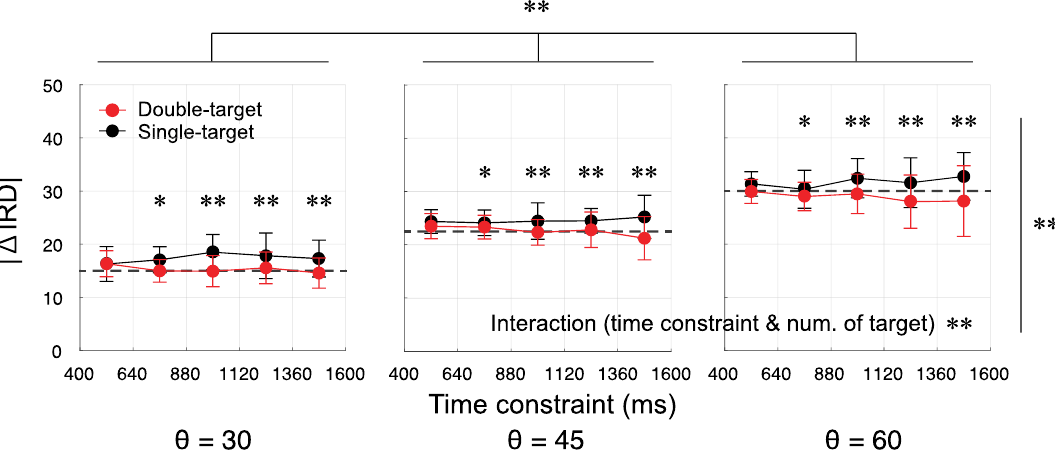
Figure 4. Comparison of the absolute value of ΔIRD between the double-targets condition and the single- target condition. Between-participant means and standard deviations of |ΔIRD| according to time constraint were shown for each target-angle condition. The ΔIRD denotes the deviation from the middle direction of the initial movement direction. The dashed line on each panel represents the |ΔIRD| for a direct reaching